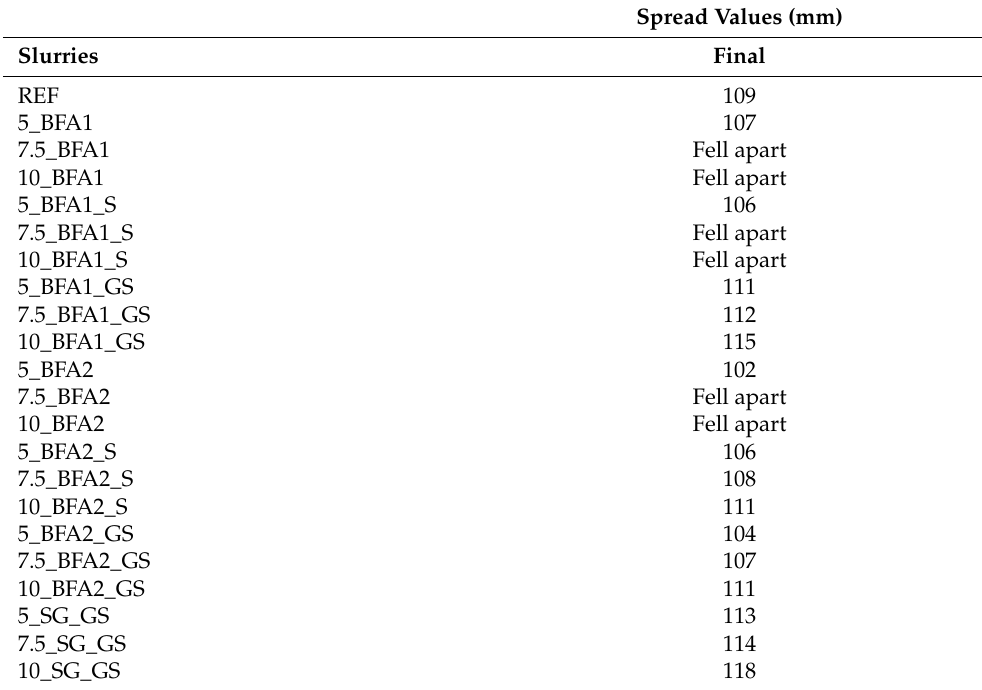
Table 3. Spread on the flow table of the prepared slurries. The initial spread value for all the slurries was 100